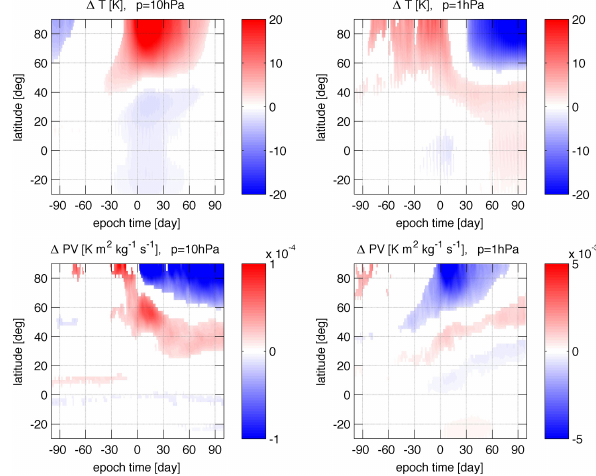
Figure 4. Composites of the anomalies (cid:49)T at 10hPa (upper left) and at 1hPa (upper right). Values are only shown if they exceed the 2 σ level. Temperature maximum of 27K is reached at 10hPa. Composites of the anomalies (cid:49) PV at 10 and at 1hPa are shown in the lower panel. The composites are based on 20 major SSWs.